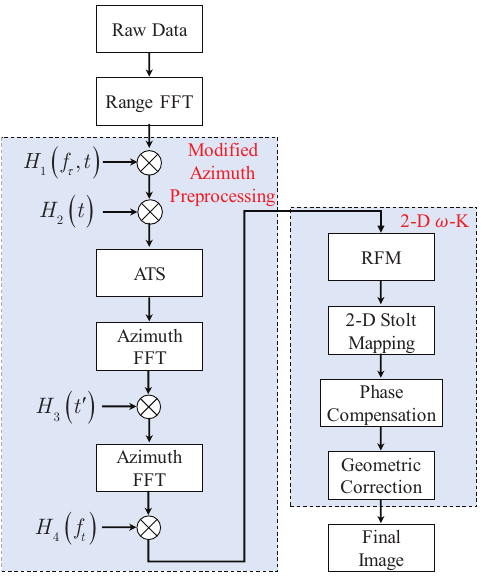
Figure 5. Flowchart of the proposed imaging algorithm for GEO-LEO BiSAR in sliding- spotlight mode.